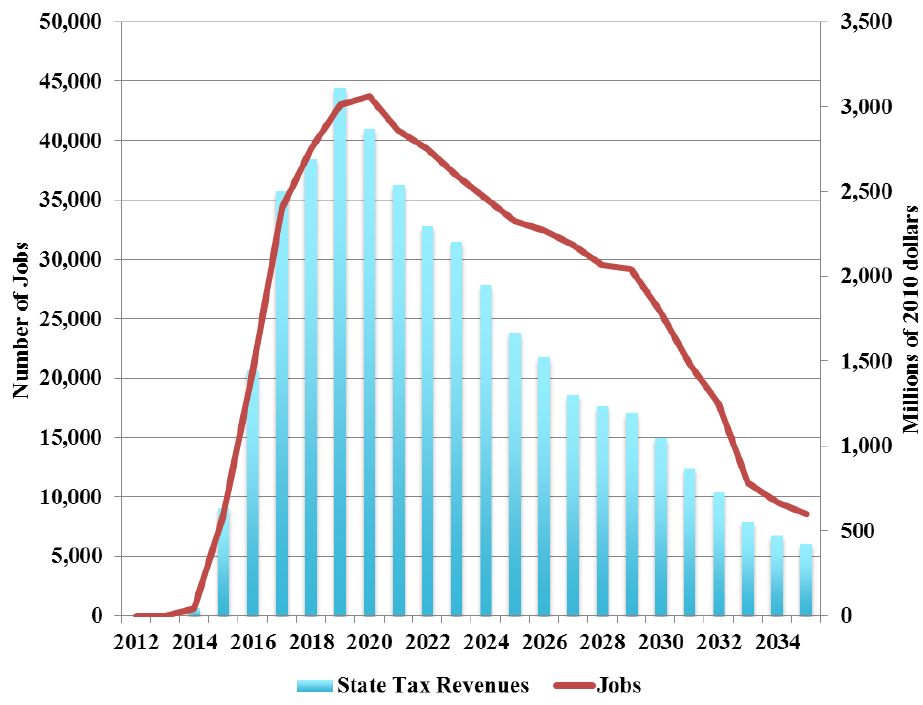
Figure 15. Jobs and tax revenues under the Santa Barbara oil